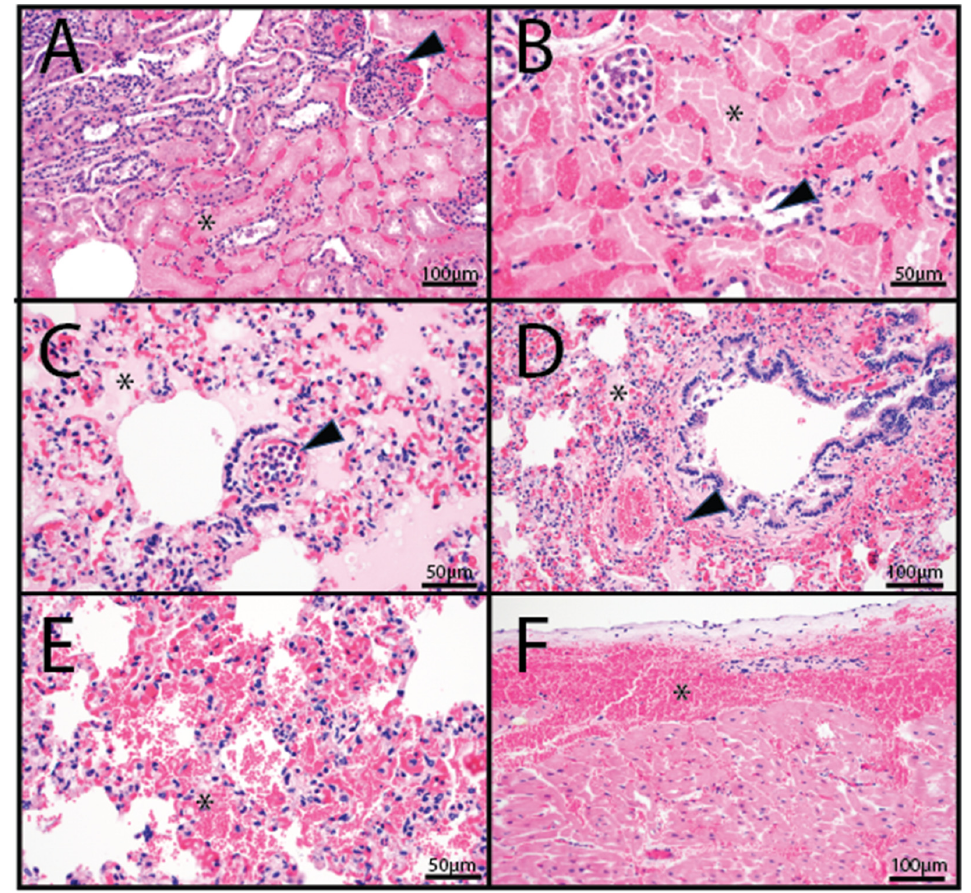
Figure 2. Histopathology photomicrographs of farmed white-tailed deer naturally infected with the U.S. novel reassortant EHDV-6 strain. ( A ) OV1248; kidney: large areas of coagulative tubular necrosis (asterisk) with interstitial and glomerular congestion (arrowhead). ( B ) OV1248; kidney: occa- sional tubules within necrotic areas contained accumulations of a basophilic to eosinophilic material admixed with individualized exfoliated epithelial cells (arrowhead). ( C ) OV1296; lung: vascular congestion and pulmonary edema (asterisk); numerous intravascular to marginated neutrophils (arrowhead). ( D ) OV1296; lung: pulmonary edema (asterisk) and perivascular and peribronchiolar hemorrhage (arrowhead). ( E ) OV1296; lung: pulmonary hemorrhage (asterisk). ( F ) OV1296; heart: subepicardial hemorrhage